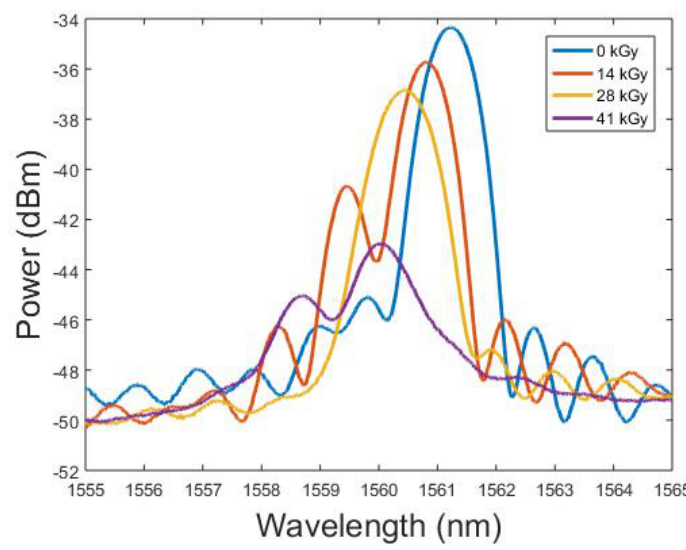
Figure 4. Spectral profile changes under gamma